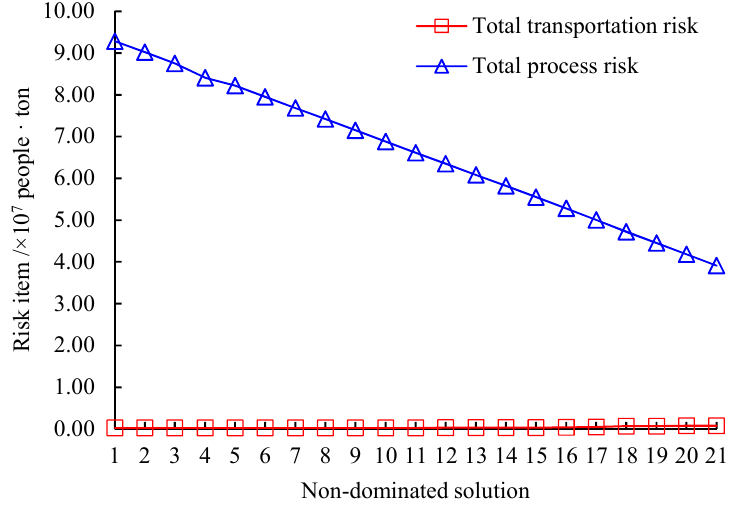
Figure 5. Risk items of non-dominated